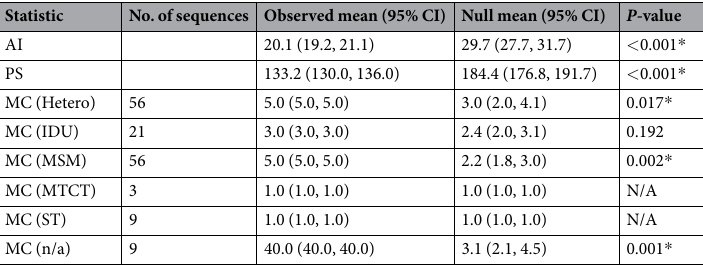
Table 5. Statistical analysis of risk group for CRF01_AE sequences. AI, association index. PS, parsimony score. MC, monophyletic clade statistic. 95% CI, 95% credibility interval. * Statistically significant (P < 0.05). Hetero, heterosexual. IDU, injecting drug user. MSM, men who have sex with men. MTCT, mother-to-child transmission. ST, sexual transmission, unspecified type. n/a, not available. N/A, not available because of the observed 95% CI contains the null 95%